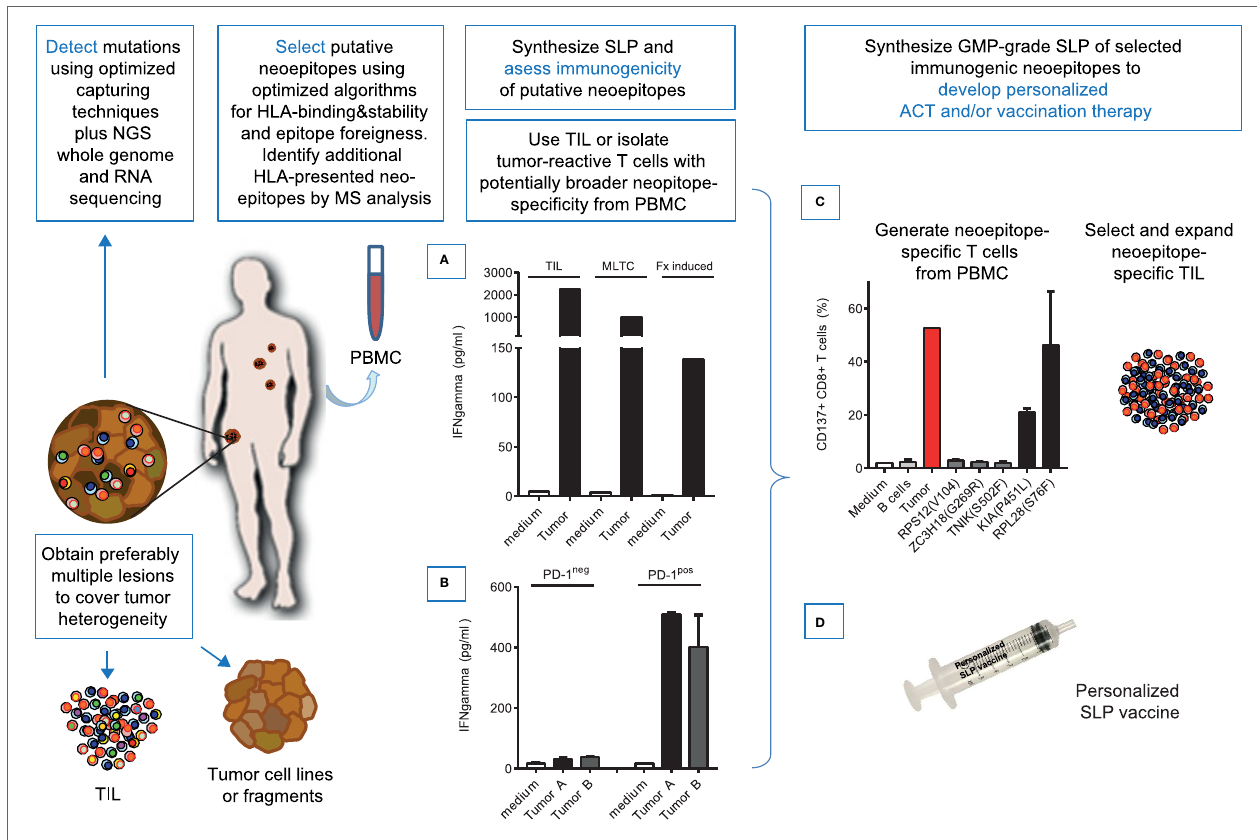
FiGUre 2 | Proposed pipeline for individualized immunotherapy exploiting neoepitope-specific T cells. Tumor tissue is excised and used for: (1) whole-exome and RNA sequencing of tumor cells and matched normal cells using optimized capturing of DNA coding regions to identify somatic mutations in expressed genes. Preferably multiple lesions are used to minimize selection of mutations with heterogeneous or lost expression, (2) to establish a tumor cell line or prepare tumor fragments for generation of neoepitope-specific, tumor-reactive T cells, and (3) to culture tumor infiltrating T cells (TIL). Putative neoepitopes can be selected based on expression of the mutated gene. Further prioritization using optimized processing, MHC-binding and stability algorithms is optional but not essential. Next, synthetic long peptides (SLPs) harboring the selected putative neoepitopes are used to assess immunogenicity using TIL. As an alternative, tumor-reactive T cells obtained by repeated stimulation of PBMC with an autologous tumor cell line (MLTC) or small tumor fragments (Fx induced), exemplified in (A) or PD-1 positive cells selected from PBMC, exemplified in (B) that are shown to contain a potentially broader repertoire of neoepitope-specific, tumor-reactive T cells can be used. Identification of immunogenic neoepitopes is assessed by IFN-gamma production of tumor-reactive T cells upon coincubation of SLP-loaded autologous B cells as APC. This approach allows identification of CD4 + as well as CD8 + epitopes (10). Subsequently, selected immunogenic neoepitopes that are shown to elicit a T cell response, can be used to select specific T cells from PBMC or TIL for ACT (c) or for personalized vaccination (D) . (c) shows that neoepitope-specific T cells can be obtained from patient’s own PBMC by repeated peptide stimulation. PBMC were stimulated at day 0 with SLP harboring selected neoepitopes and stimulated at week 2 with PHA-blasts loaded with the corresponding short minimal CD8 + epitopes. After 4 weeks, the majority of the obtained cells were CD8 + T cells that recognized autologous B cells loaded with the specific SLP, as well as autologous tumor cells. Thus obtained enriched neoepitope- and tumor-reactive T cells can be expanded and used for ACT. Alternatively or in combination with ACT, prevalent neoepitope-specific T cells can be boosted by vaccination with SLP harboring the selected neoepitopes plus an immunostimulatory adjuvant to induce a robust immune response and/or to further support transferred neoepitope-specific T cells in vivo